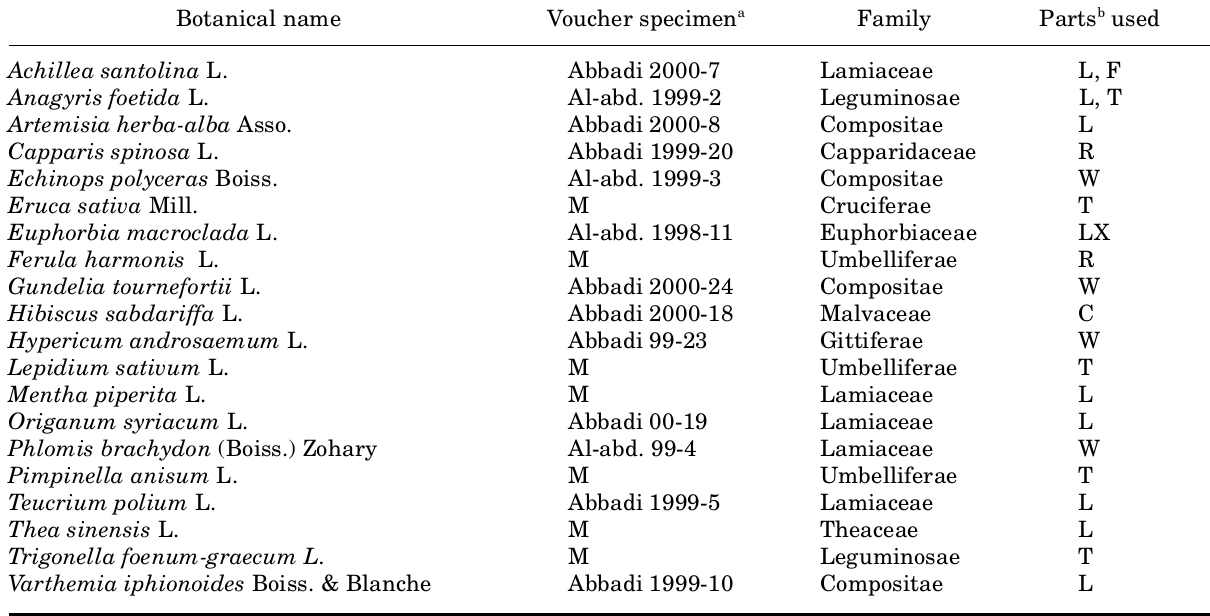
Table 1. Ethnobotanic data of plants